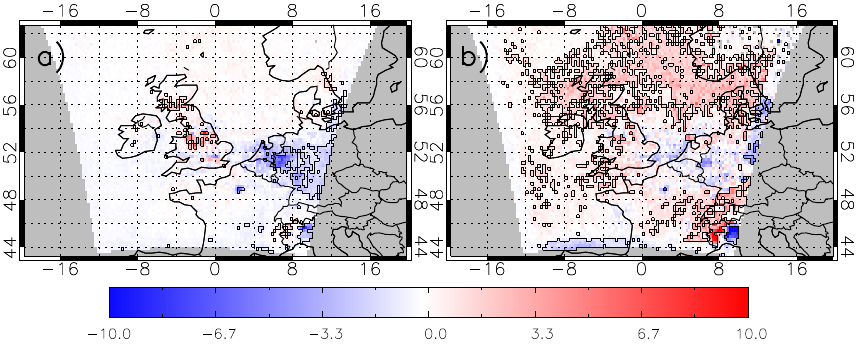
Figure 5. Mean bias in tropospheric NO 2 column ( × 10 15 moleculescm − 2 ), 2006, between AQUM Run C (AKs applied) and OMI for (a) summer (RMSE = 3.68 × 10 15 moleculescm − 2 and FGE = 0.65) and (b) winter (RMSE = 5.12 × 10 15 moleculescm − 2 and FGE = 0.63). The RMSE and FGE are over the UK between 8 ◦ W–2 ◦ E and 50–60 ◦ N and black polygoned regions show significant differences. Also the same for mean bias plots in Figs.